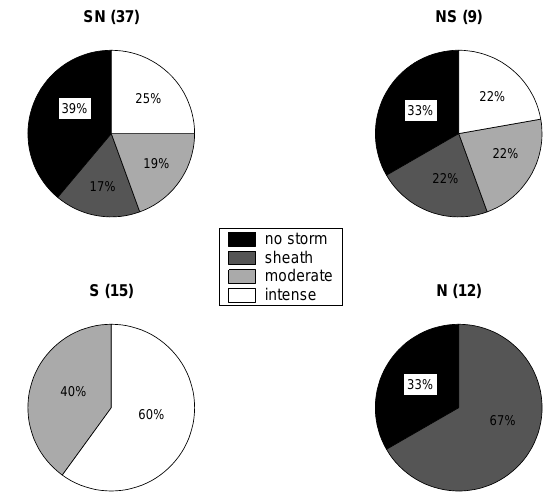
Fig. 14. The effect of the flux rope type to the geoeffectivity. Num- bers in the parentheses show the total numbers of MCs identified in each category. Different colors demonstrate the different geomag- netic response: no storm at all, D st > − 50nT (black); sheath region generated a storm (dark gray); MC caused a moderate storm (light gray); MC caused an intense storm